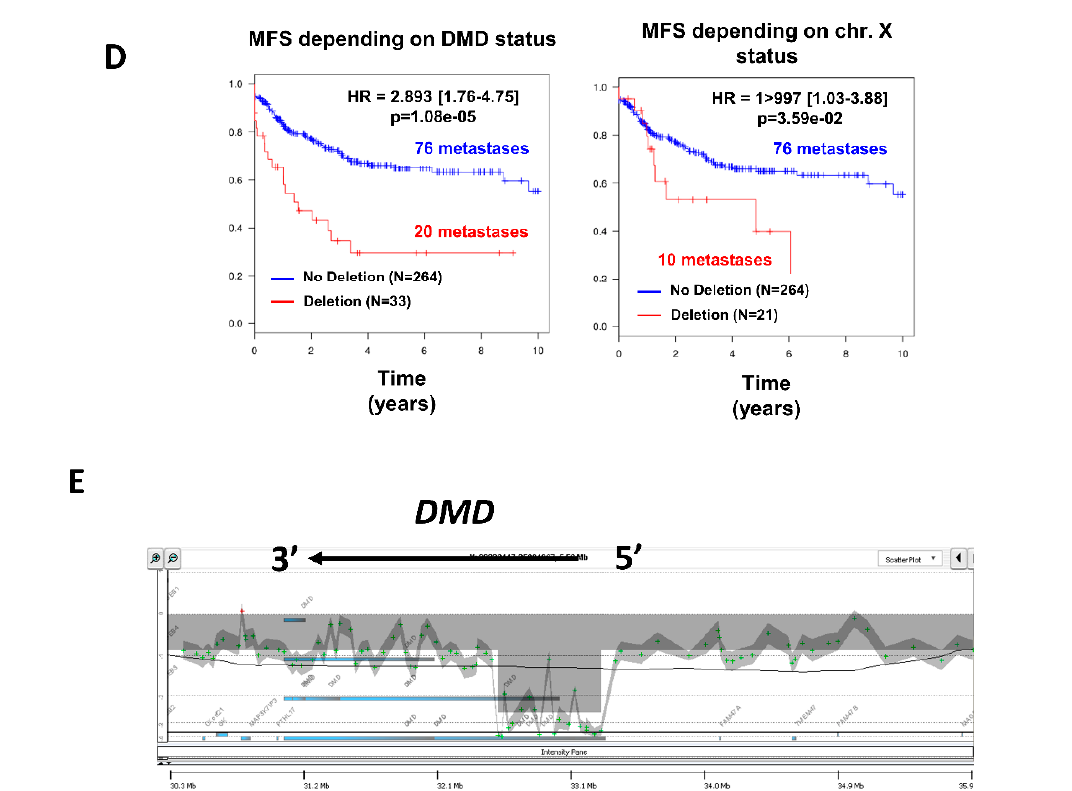
Figure 1. Deletion of DMD gene was significantly associated with metastatic evolution. ( A ) DMD expression determined by TaqMan comparing tumors with (in green) or without (in red) DMD deletion. ( B ) Kaplan–Meier analysis of metastasis-free survival (MFS) of sarcoma patients divided into two groups according to their DMD status (non-deleted in blue, DMD deleted in red). ( C ) Chromosome X (chr. X) analyzed by GCH array: losses and gains are represented in green and red, respectively. Three types of deletion a ff ecting DMD are illustrated: deletion of entire chr. X, of the short arm of chr. X, or targeting only DMD (indicated by a red arrow). ( D ) Kaplan–Meier analysis of metastasis-free survival of sarcoma patients divided into two groups: (in blue) patients displaying no deletion and (in red) patients displaying either targeted DMD deletion (left plot) or deletion of p-arm / entire X chromosome (right plot). ( E ) Zoom on DMD genomic status on a GCH-array profile. Illustration of a typical deletion targeting the DMD